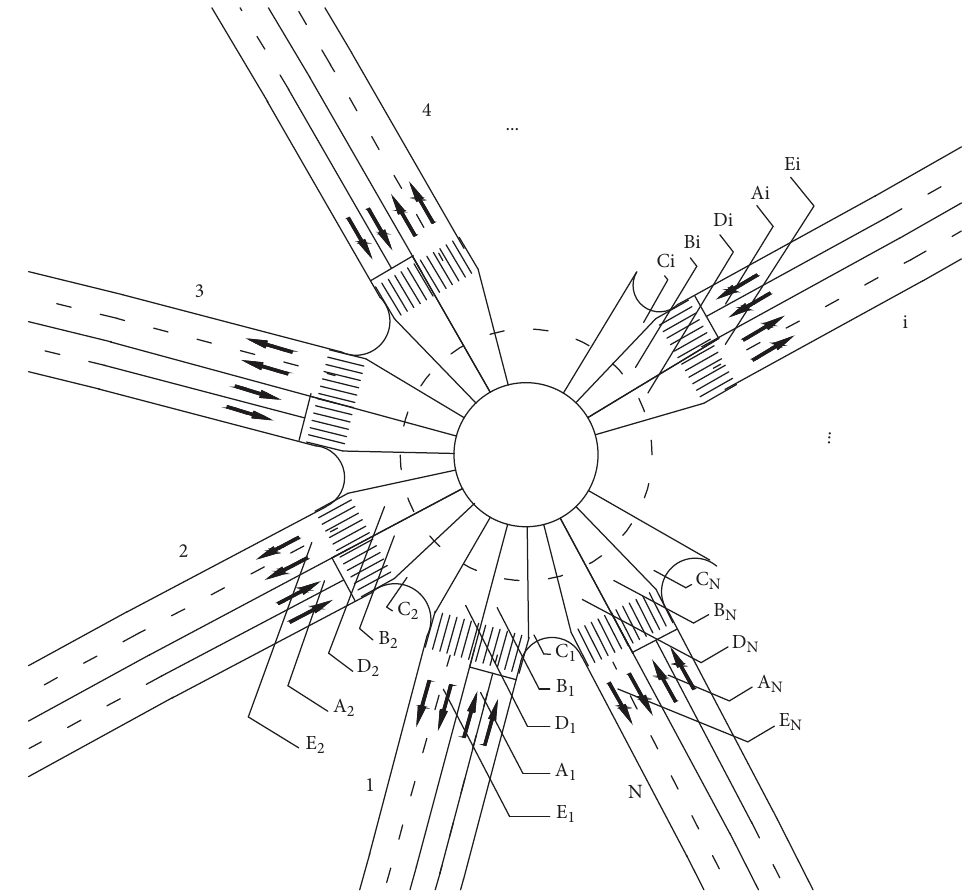
Figure 1: Structure of a multileg